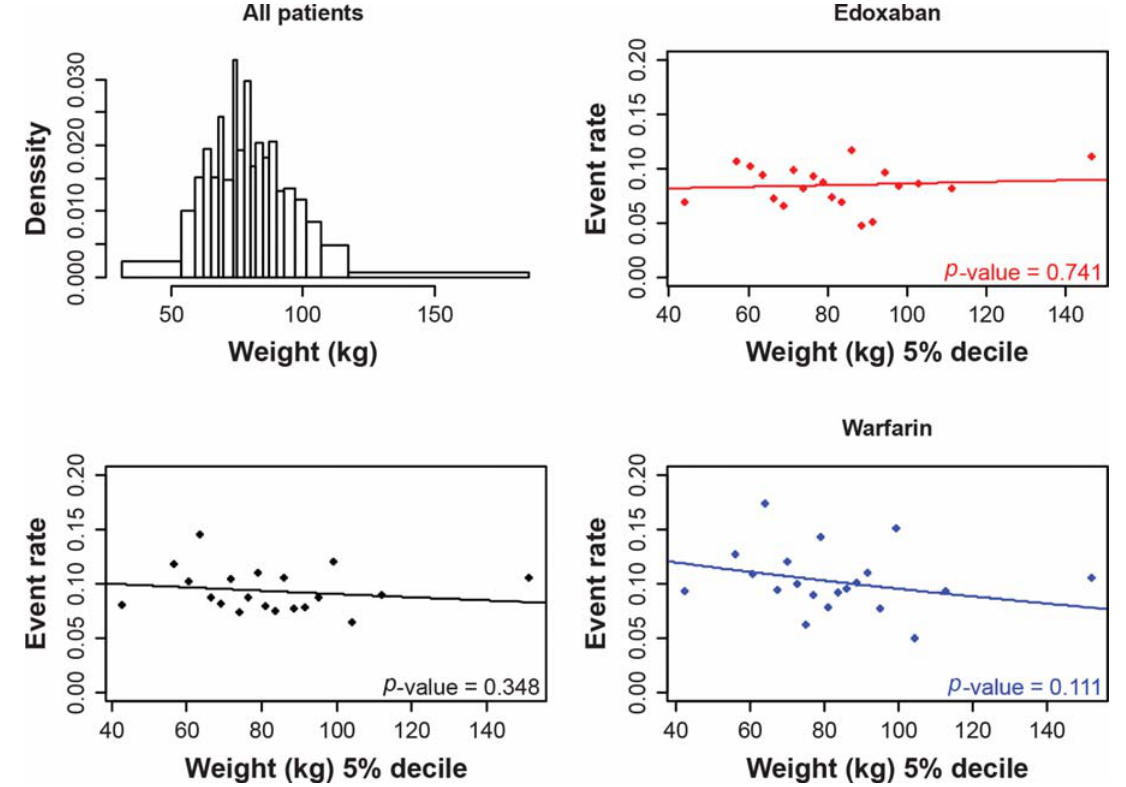
Fig. 6 The relationship between clinically relevant bleeding and body weight, overall and by treatment